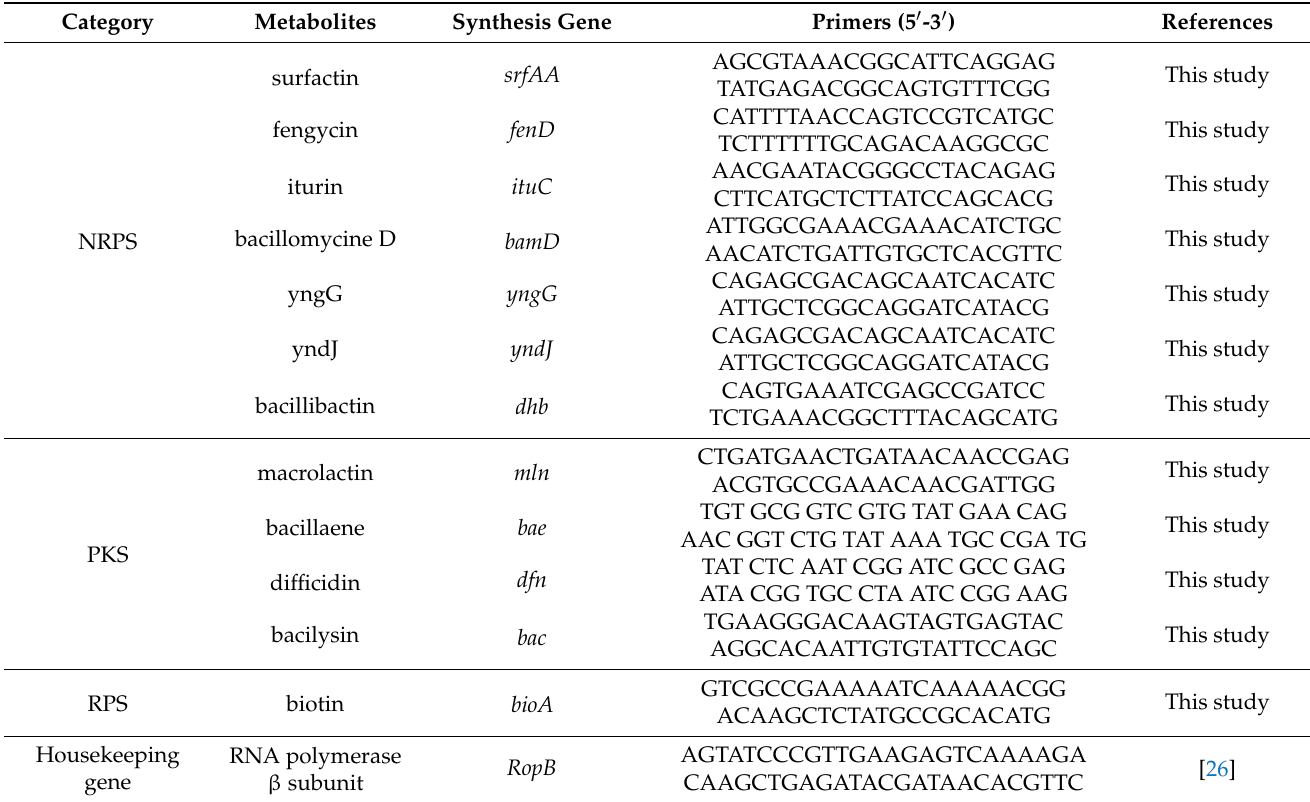
Table 2. The designed specific primers and housekeeping gene for